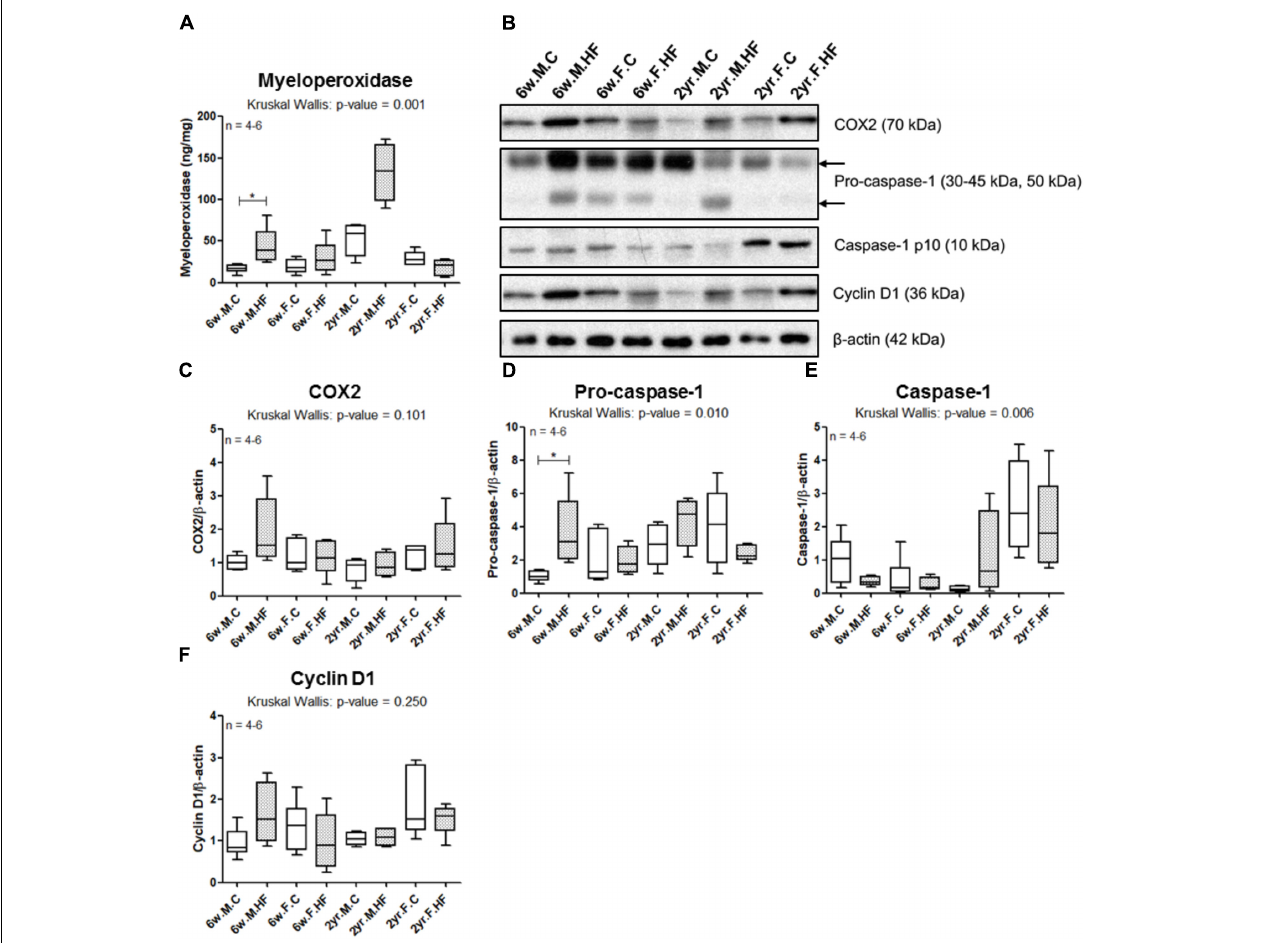
FIGURE 7 | Inflammation and proliferation markers in colonic mucosa. Myeloperoxidase concentration (A) was assessed by ELISA. (B) Western blot of COX2, pro-caspase-1, caspase-1 p10, and cyclin D1 was performed with colonic mucosa samples. Band intensities of COX2 (C) , pro-caspase-1 (D) , caspase-1 p10 (E) , and cyclin D1 (F) were quantified by densitometry, adjusted to that of β -actin, an endogenous control, and normalized to the mean value of 6w.M.C group. Box and whiskers (Turkey): the central line on each box, median; the edges of boxes, 25th and 75th percentiles; whiskers, maximum and minimum values of the data. p -Values to Kruskal–Wallis test are designated on the figure; ∗ p < 0.05 according to Mann–Whitney U -test with Holm–Bonferroni correction. 6w, 6-week-old; 2yr, 2-year-old; M, male; F, female; C, control; HF, high-fat